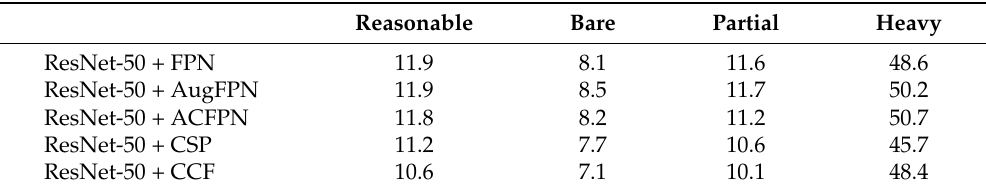
Table 3. Ablation study of different neck module on the Citypersons dataset.